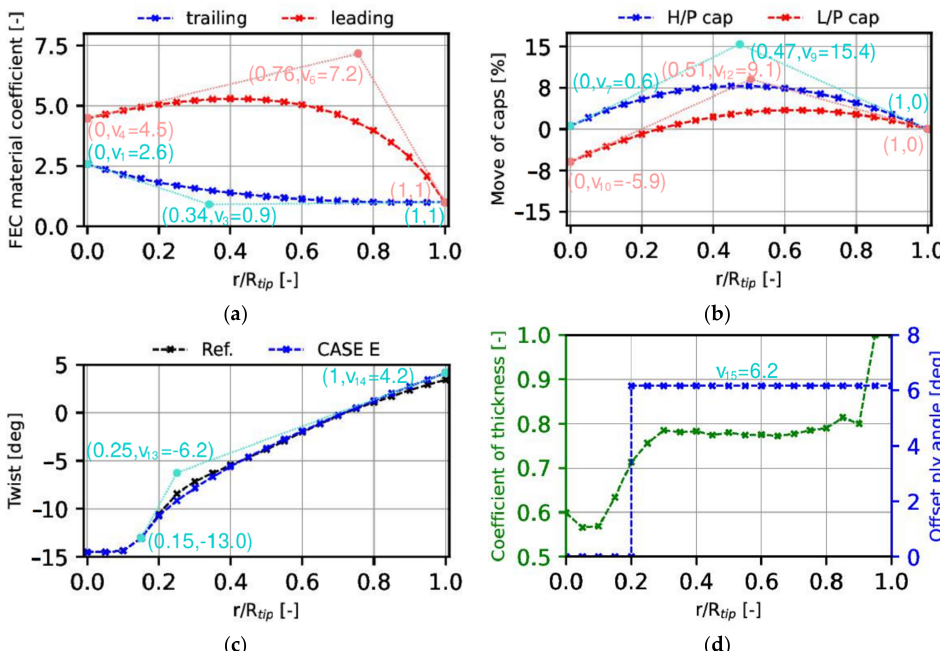
Figure 12. CASE E: distribution of ( a ) FEC material approach, ( b ) FEC geometrical approach, ( c ) twist and ( d ) offset ply angle of ‘UNIAX’ material and coefficient of wall thickness.